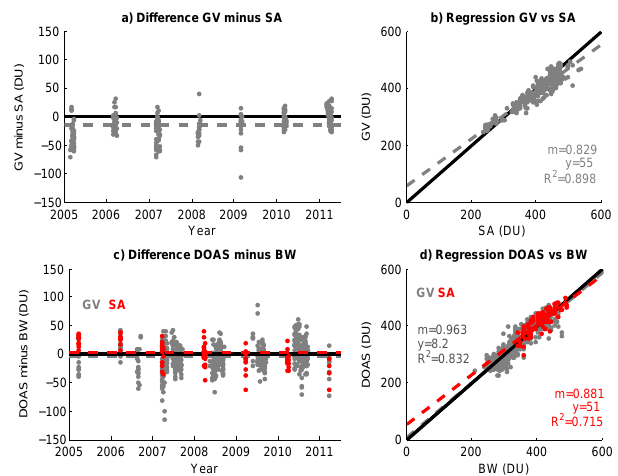
Fig. 10. (a) Absolute difference (circles) between GBS and SAOZ ozone total columns. (b) Correlation between GBS and SAOZ ozone total columns. (c) Absolute difference (circles) between GBS (grey) and SAOZ (red) minus Brewer ozone total column mea- surements. (d) Correlation for GBS (grey) and SAOZ (red) versus Brewer ozone measurements. In (a) and (c) , the solid black lines indicate the zero line and the dashed lines indicate mean absolute differences. In (b) and (d) , the solid black lines indicate the 1-1 line and the dashed lines indicate linear fit ( m =fitted slope, y =fitted